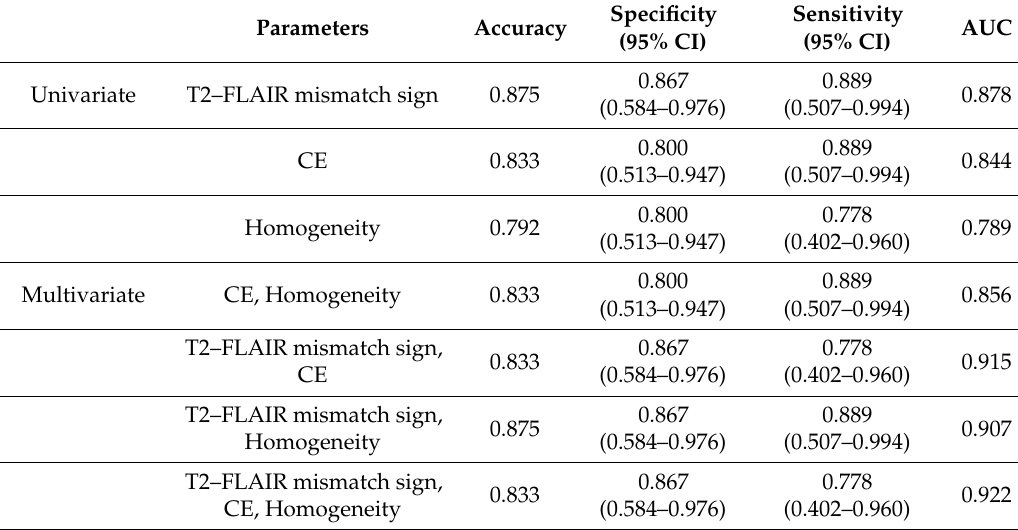
Figure 3. ROC curve of the full model. The full model was characterized by significant diagnostic accuracy (0.833) and very high AUC (0.922). ROC, receiver operating characteristic curve; AUC, area under the curve. Table 6. Diagnostic accuracy table. Sensitivity and specificity in predicting the IDH status were the highest when the T2–FLAIR mismatch sign and homogeneity were co-registered.